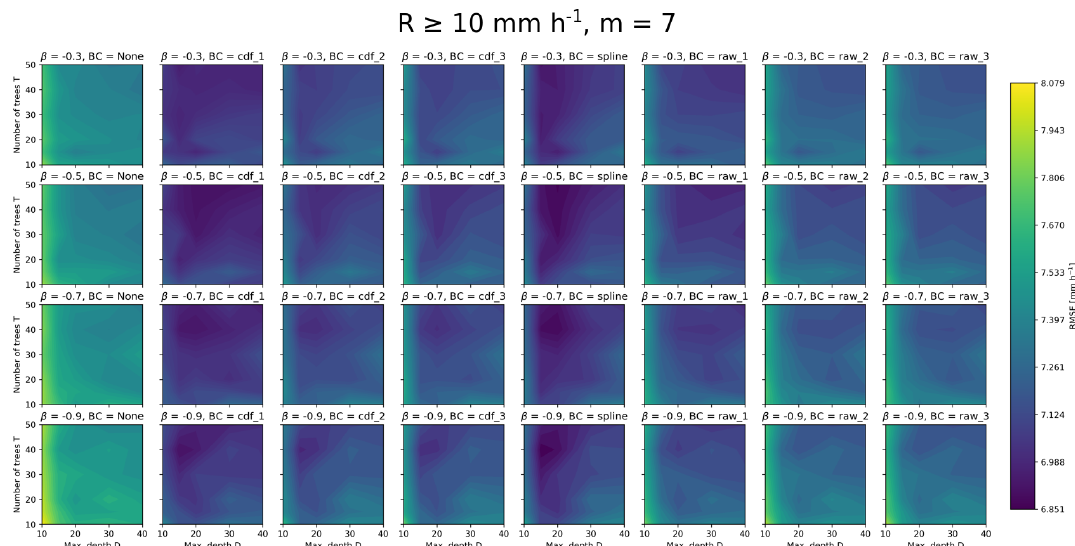
Figure B2. Overall RMSEs for observations ≥ 10mmh − 1 as a function of number of trees, maximum depth, β parameter and bias-correction method. The maximum number of randomly chosen variables at each split is here set to